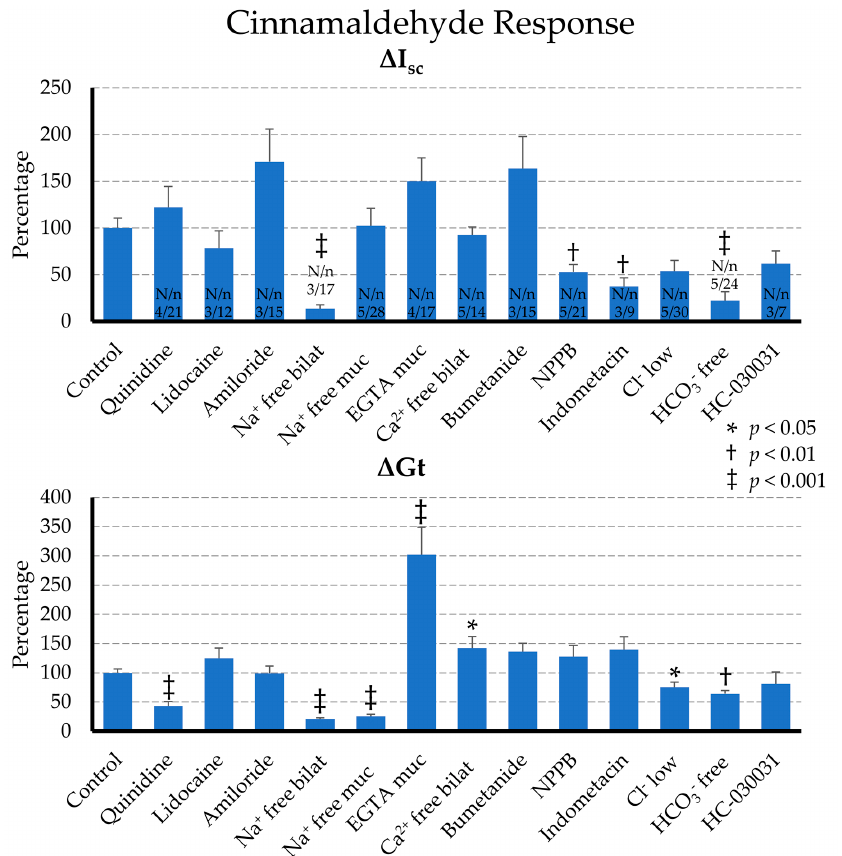
Figure 4. Comparison of the effect of cinnamaldehyde (1 mmol·L − 1 ) on the short circuit current ( Δ I sc ) and the conductance ( Δ G t ) of the colonic mucosa from young pigs (controlled in-house study) in Ussing chambers after preincubation with different blockers, or after the ion replacement. In order to allow a comparison of the data from different sets of experiments, the differences (deltas) were calculated by subtracting the peak value of the cinnamaldehyde response in the 15 min period after addition of cinnamaldehyde from the baseline value before addition. The delta values of the control tissues of each animal were set to 100%, and the deltas of the treated tissues were calculated as a percentage of the control tissues of the animal in question. Significant differences versus the control group are marked as *, †, or ‡ ( P < 0.05, P < 0.01 or P < 0.001). For the concentrations of the blockers and the composition of the solutions used, see the results and the Supplementary Materials. N/n = number of animals/number of tissues, which were identical for G t and I sc ; muc = mucosal; bilat = bilateral. Further tissues were treated with the anion channel blocker NPPB at a concentration of 0.5 mmol·l − 1 on the mucosal side (N/n = 5/21), which decreased the baseline I sc by Δ I sc = − 0.20 ± 0.047 µeq·cm − 2 ·h − 1 ( P < 0.001) and the baseline G t by Δ G t = − 0.95 ± 0.32 mS·cm − 2 ( P < 0.008). After the subsequent addition of cinnamaldehyde, a significantly smaller Δ I sc was